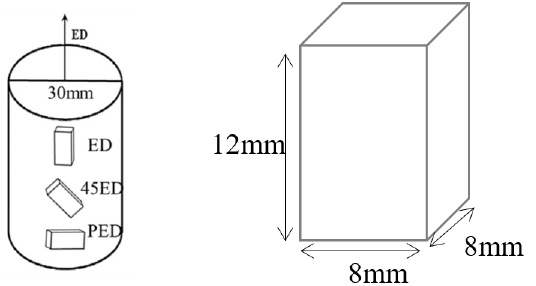
Figure 1. Extruded magnesium alloy material: three sample orientations drawing ( left ), specimen size drawing ( right